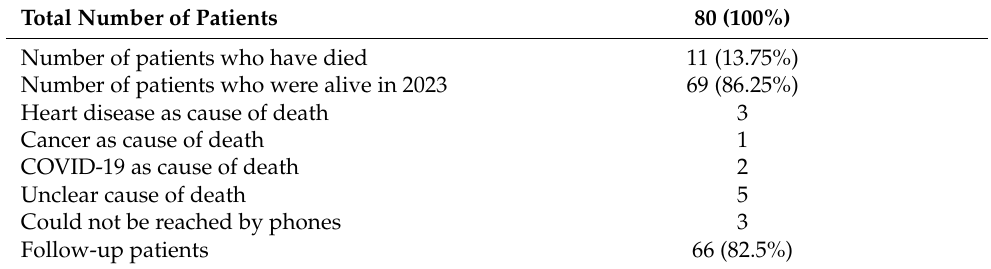
Table 5. Proportion of deceased patients and patients alive today and causes of death. Total Number of Patients 80 (100%) Number of patients who have died 11 (13.75%) Number of patients who were alive in 2023 69 (86.25%) Heart disease as cause of death 3 Cancer as cause of death 1 COVID-19 as cause of death 2 Unclear cause of death 5 Could not be reached by phones 3 Follow-up patients 66